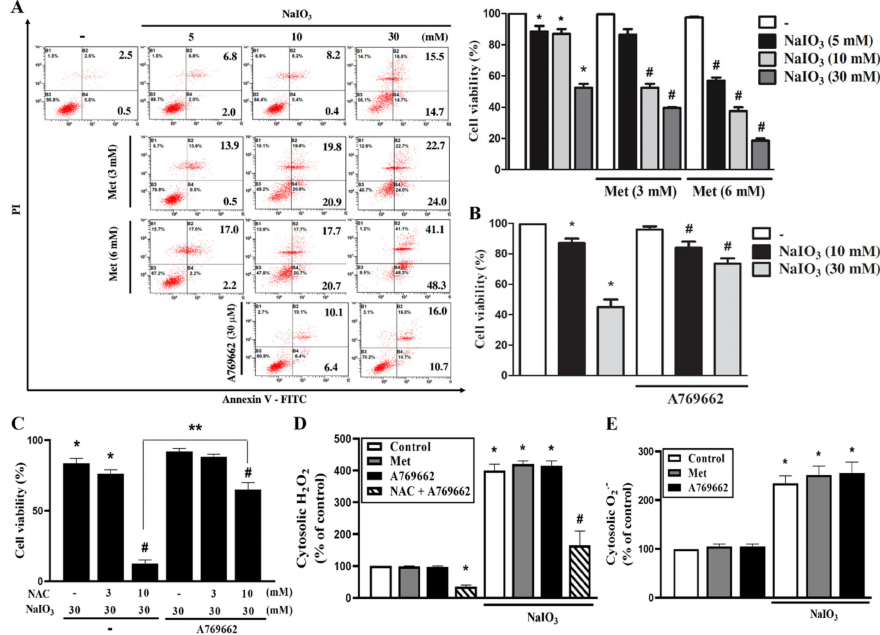
Figure 2. A769662, but not metformin, reverses the NaIO 3 -induced cytotoxicity. Cells were pretreated with metformin (3 mM, 6 mM) ( A ), A769662 (30 µ M) ( B ) or NAC (3, 10 mM) ( C ) followed by NaIO 3 stimulation in di ff erent concentrations for 18